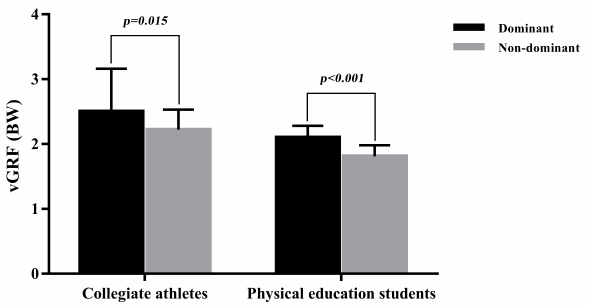
Fig. 4. Comparison of lower limb vGRF of dominant and non- dominant leg at